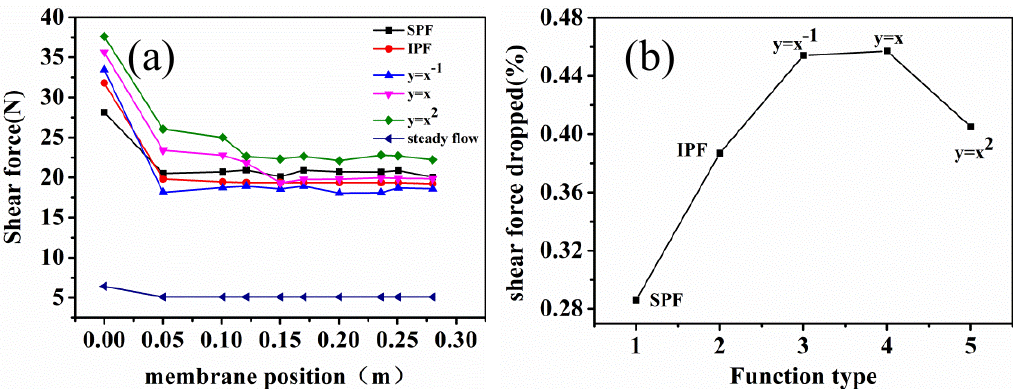
Figure 6. Comparison of the shear force of different function feeding modes, ( a ) shear force variation at different membrane positions, ( b ) the shear force dropped value.